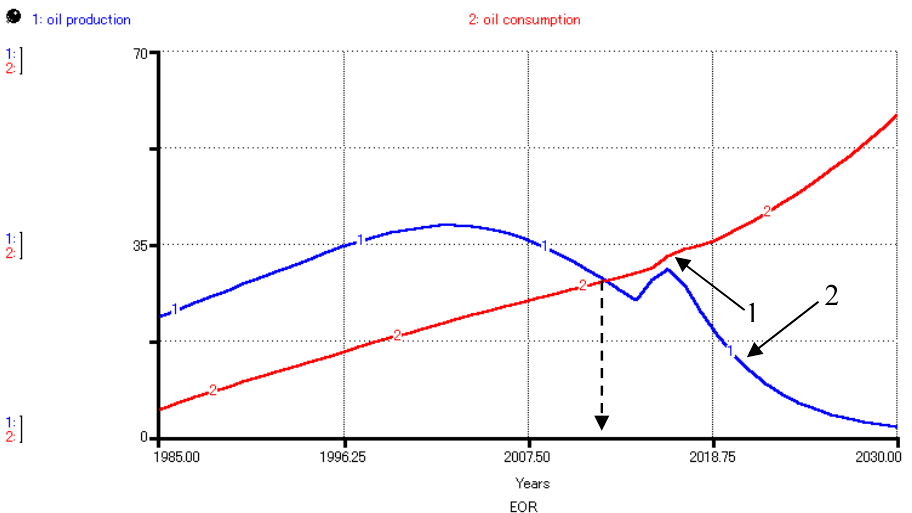
Figure 17. Oil production and consumption in the EOR